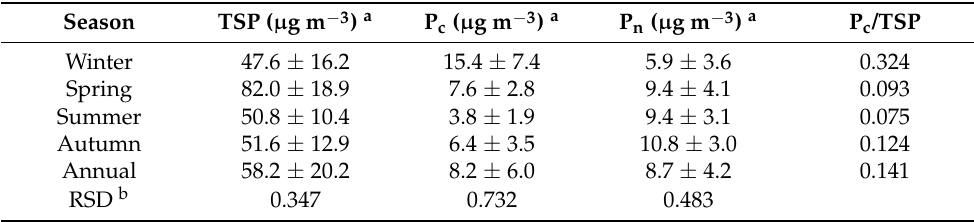
Table 2. Seasonal atmospheric concentrations of TSP, P c , and P n concentrations as well as P c /TSP ratio in